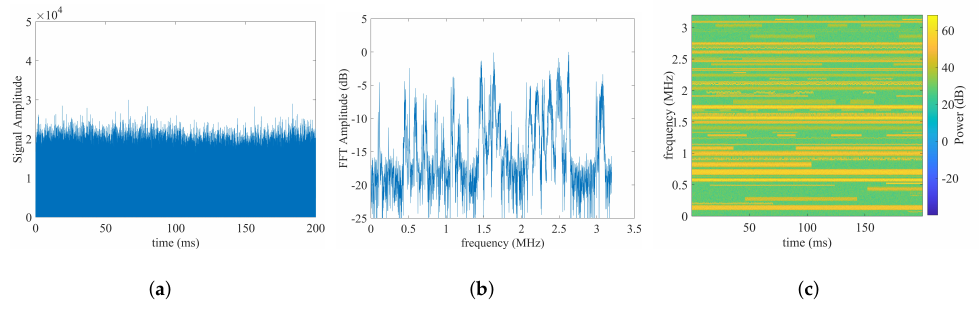
Figure 1. The time content, frequency content, and spectrogram of an example RF capture with a sampling rate of 6.4 MHz and a duration of 200 ms, respectively. ( a ) signal amplitude vs. time; ( b ) FFT magnitude vs. frequency; ( c ) time-frequency